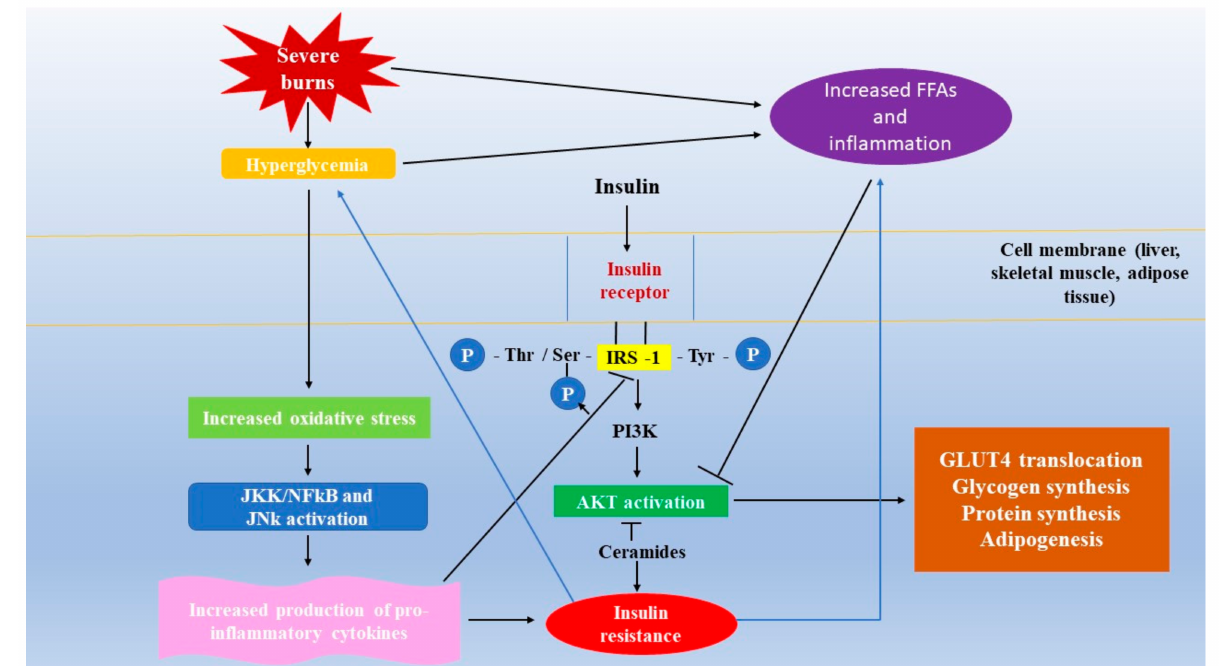
Figure 3. Insulin resistance in severe burns. Severe burns are characterized by hyperglycemia, which further promotes oxidative stress (OS) by increased production of reactive oxygen species (ROS), activating the JNK and I κ B kinase- β (IKK- β )/(NF- κ B) pathways, and increased production of proinflammatory cytokines. After the binding of insulin to its receptor, receptor autophosphorylation takes place, and members of the insulin receptor substrate (IRS) family are phosphorylated on Ser/Thr and Tyr residues. Phosphoinositide 3-kinase (PI3K) further activates protein kinase B or AKT, promoting GLUT translocation to the cell membrane, protein and glycogen synthesis, and adipogenesis. Severe burns are characterized by lipolysis, determining an increased production of free fatty saturated acids (FFAs) and ceramides, which have an inhibitory effect on the PI3K/AKT/mTOR signaling pathway, hence inducing insulin resistance. “ ” shows an inhibitory